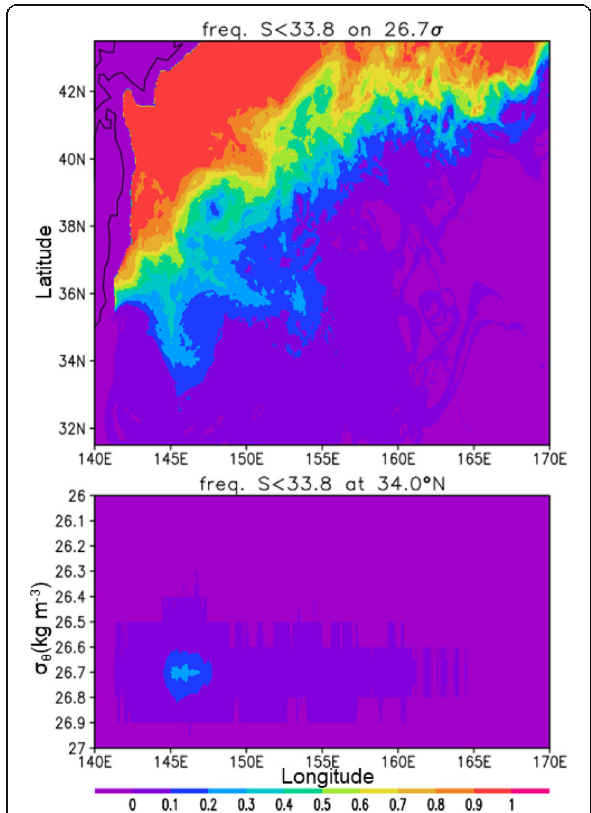
Fig. 14 Appearance rate distributions of a lower salinity (< 33.8; PSS- 78) on the 26.7 σ θ isopycnal surface and b along the zonal section at 34.0° N. Appearance rate is calculated from the number of appearance days (< 33.8) divided by 365 days using the daily mean data in 2003 of the OFES. Appearance rate of 1.0 means the area where the lower salinity value comes up for 365 days, while 0.0 means that the lower values do not